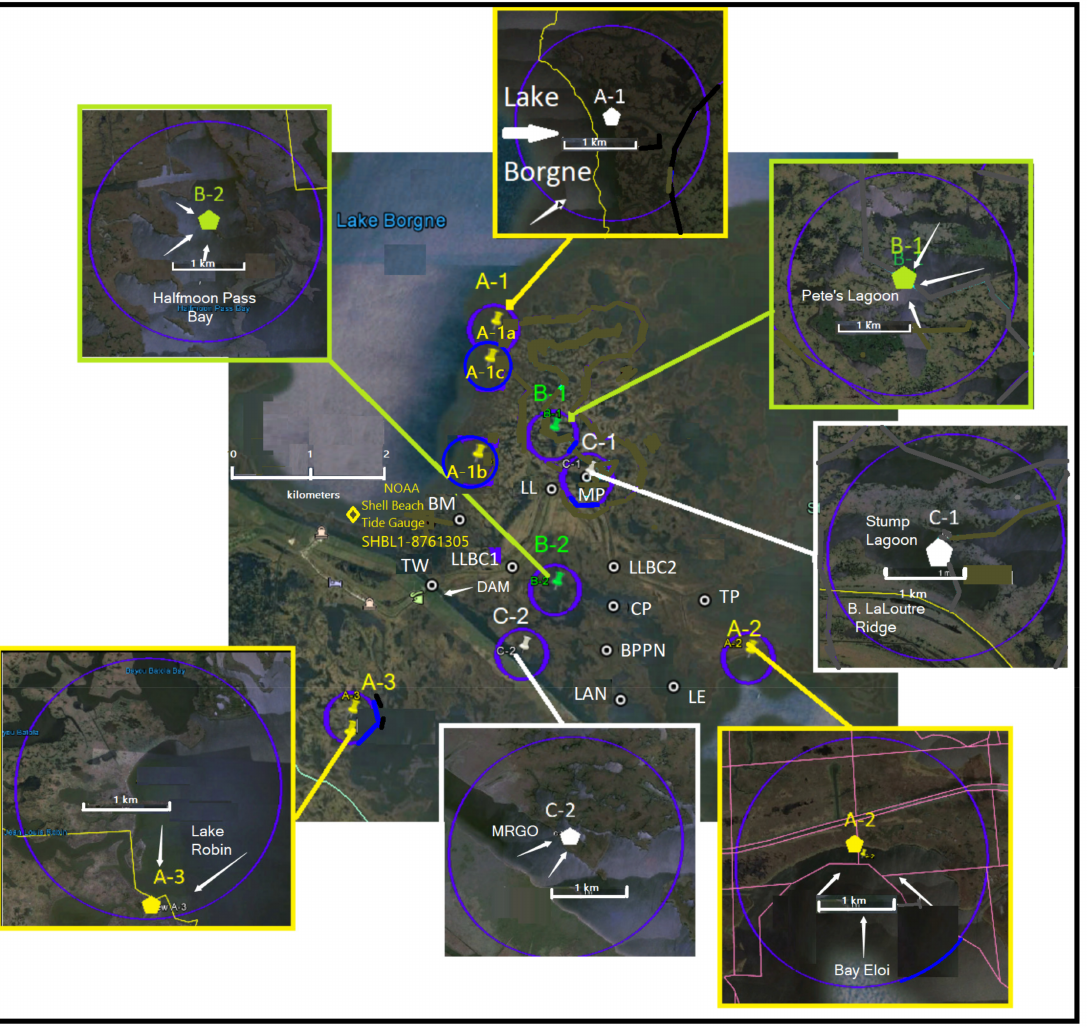
Figure 2. 2018 Marsh and Shoreline Study sites on BLMC and LKEU properties (hexagons) in Biloxi Marsh. Arrows indicate principal wave directions. White labeled sites are Rounsefell [70] water quality stations. NOAA Shell Beach Tide Gauge and Meteorology Station SHBL1-8761305 is marked by yellow diamond in southern Lake